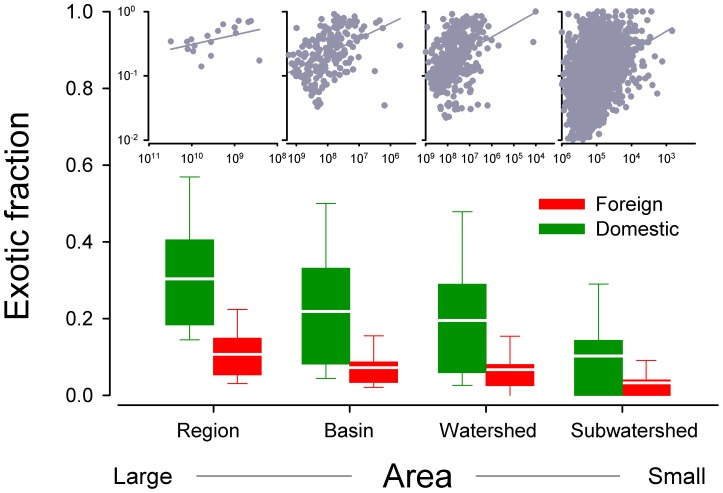
Relationship between the fractions of both foreign and domestic exotic fish and surface area across multiple spatial scales.Foreign exotic fish accounted for a much lower overall exotic proportion than domestic exotic fish (The horizontal bars represent means across the four spatial scales). Note one sub-watershed from Florida with extremely high exotic fish richness is regarded as an outlier and then removed from the analysis.